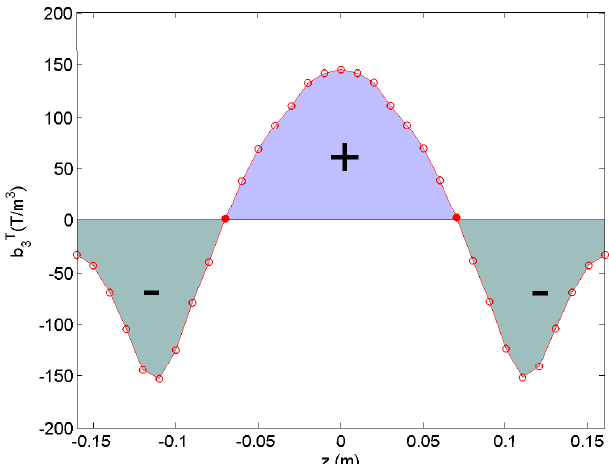
FIG. 13. (Color) Third order coefficient of the transverse ex- pansion of the magnetic field along the beam trajectory in the central semiperiod as a function of z . The part of the plane which gives positive and negative contributions to I corresponding to the inversion of sign of b